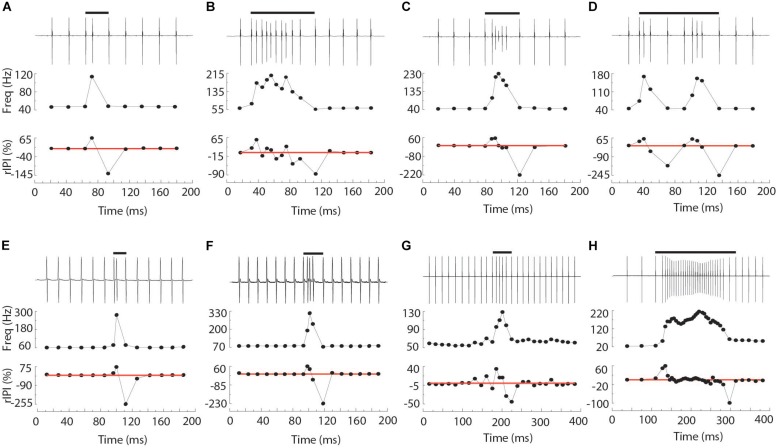
Representative chirps from Steatogenys
(A–D), Microsternarchus
(E,F), and Brachyhypopomus
(G,H). In all panels, the upper trace shows the recordings of the chirp and several preceding and subsequent intervals. The total chirp duration is marked by the horizontal black bars. The lower subpanels show the instantaneous frequency of all intervals shown and their relative reduction from baseline (IPI r) as a percentage. The thin red lines are plotted to highlight the axis position of 0% changes from baseline.